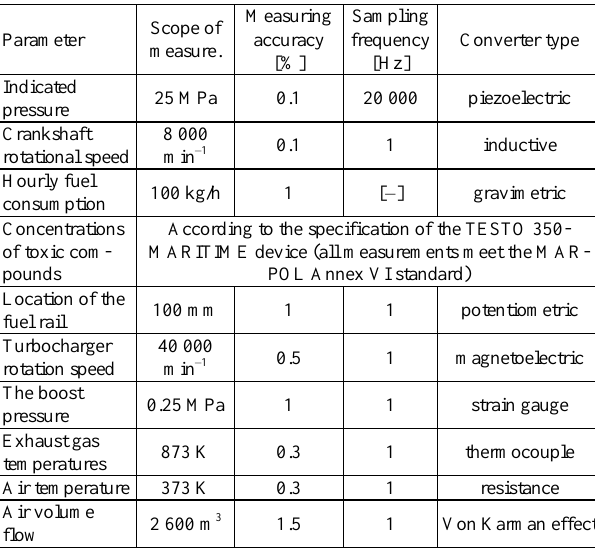
Table 2. Parameters of the measuring system of the SULZER engine, type 6AL 20/24